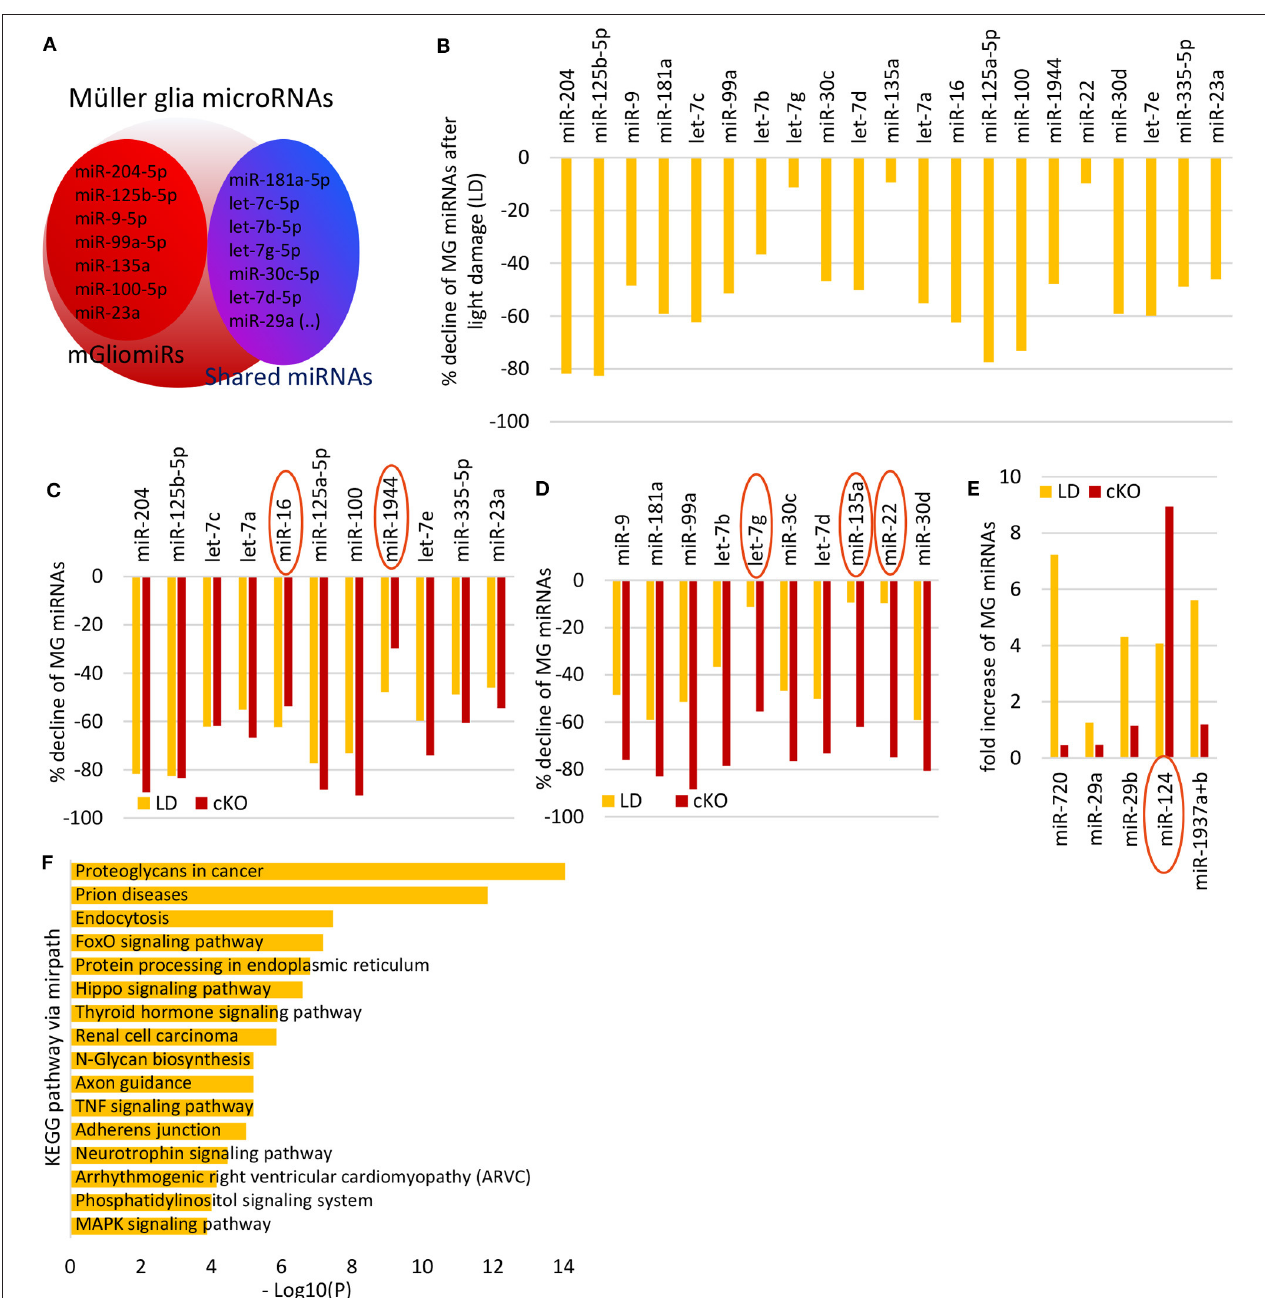
FIGURE 3 | Müller glia miRNA expression after light damage. (A) Schematic of miRNA highly expressed in MG i.e., mGliomiRs and shared miRs (modified after Wohl and Reh, 2016). (B) Percent decline of the top 21 highly expressed MG miRNAs after 7 days light damage compared to normal MG (cutoff 3,000 counts). (C) miRNAs with similar declined levels after light damage as after Dicer deletion (in percent). (D) miRNAs with less declined levels after light damage as after Dicer deletion (in percent). (E) Fold increase of 5 miRNAs that increased after 7 days light damage (cutoff 5,000 counts) compared to controls. (F) DIANA-mirPath v.3 analysis of the 21MG miRNAs that declined after light